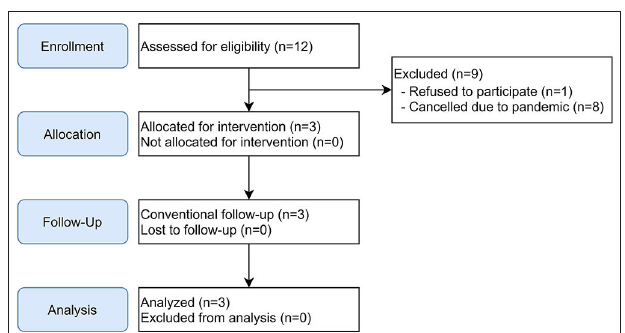
FIGURE 4 | Flowchart for non-randomized clinical